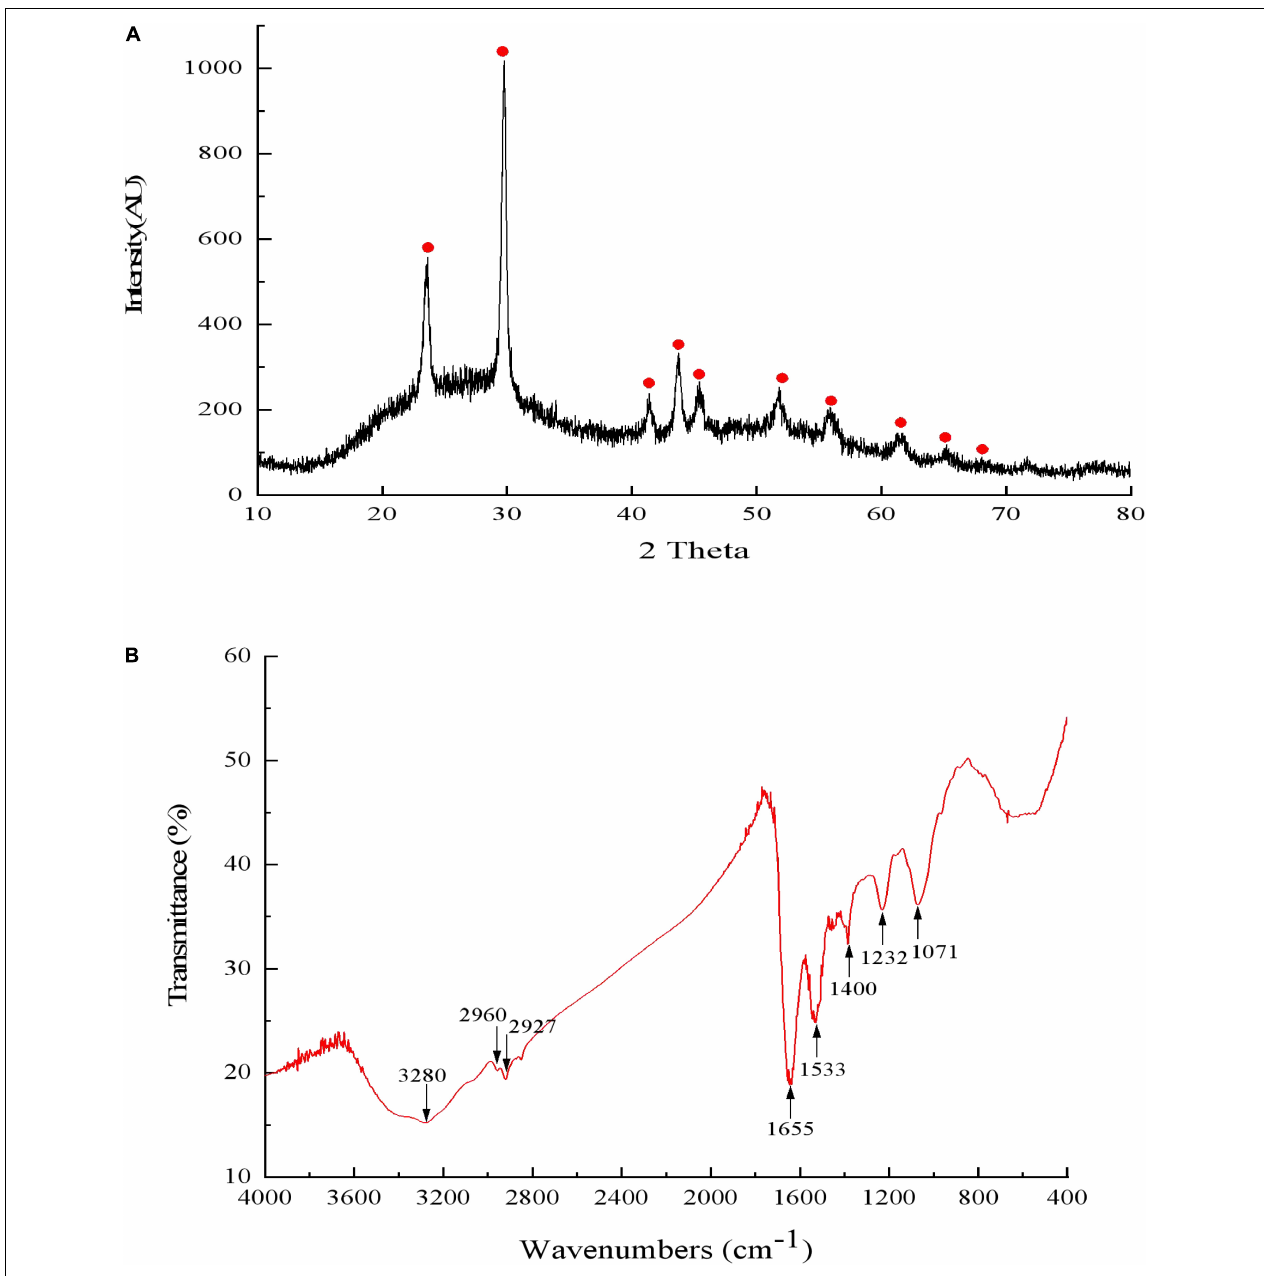
FIGURE 9 | The X-ray diffraction spectrogram (A) and FTIR spectrum (B) of SeNPs synthesized by Proteus mirabilis